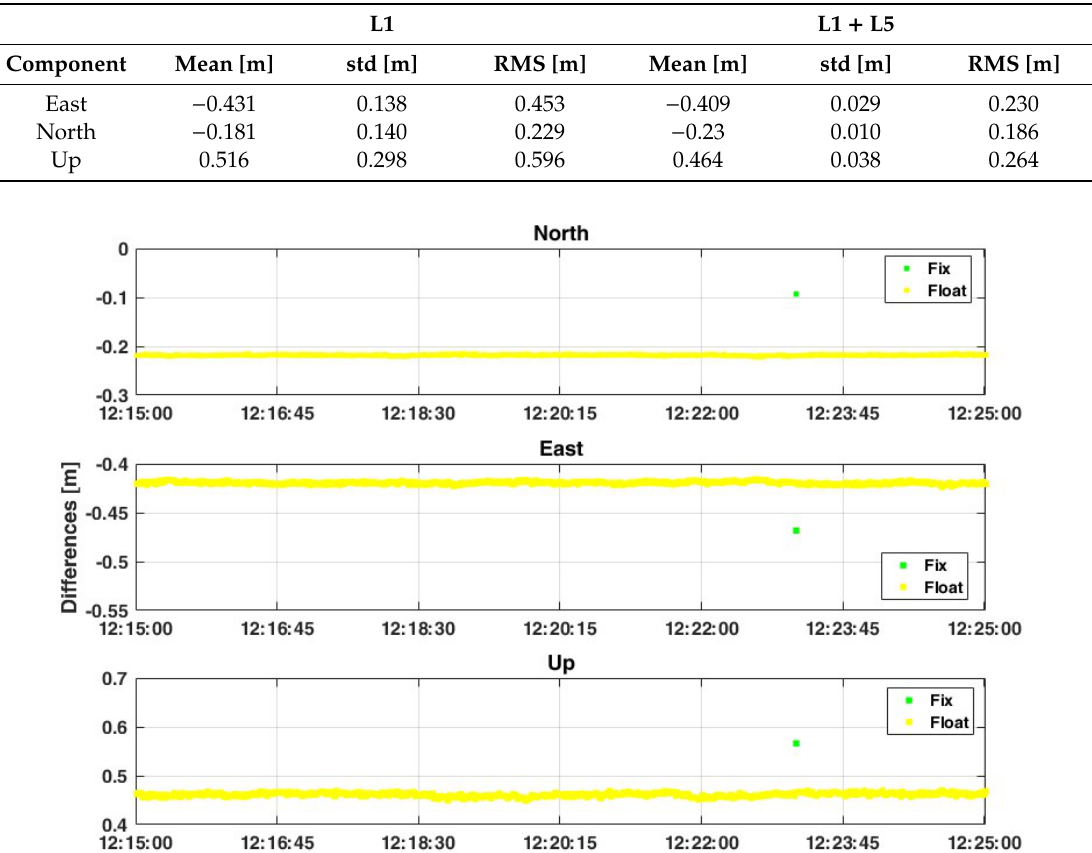
Figure 7. Positioning results considering case 1, with GPS-only constellations, L1 + L5 frequencies, “continuous” method for the ambiguity resolution and ratio = 30. Table 5. Comparison of FIX+FLOAT solutions considering L1 and L1+L5 frequencies.